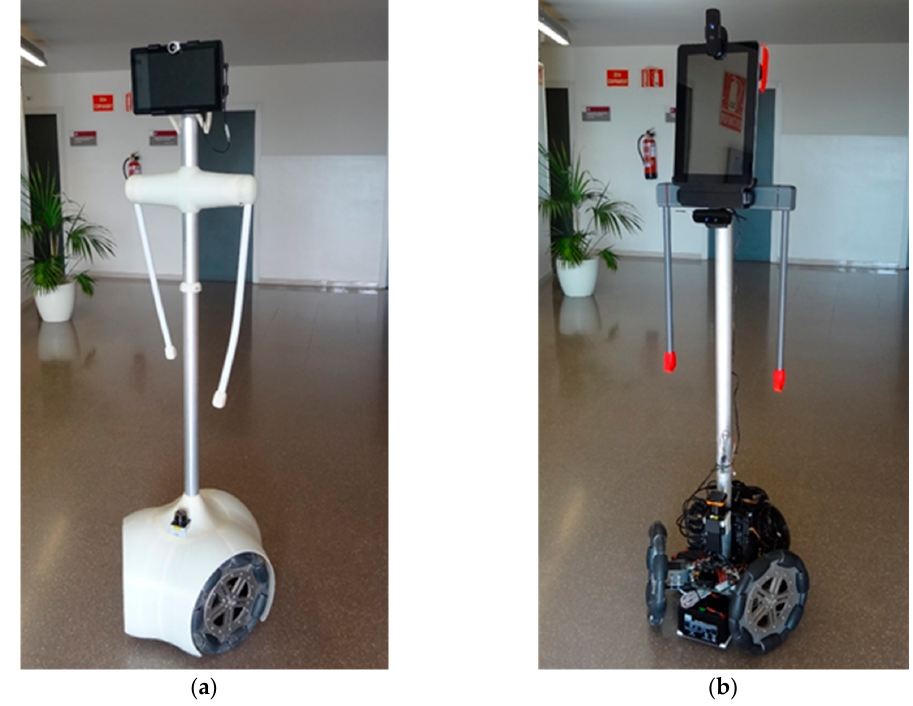
Figure 2. Images of the two mobile robot prototypes analyzed; ( a ) APR-1, ( b ) APR-2.